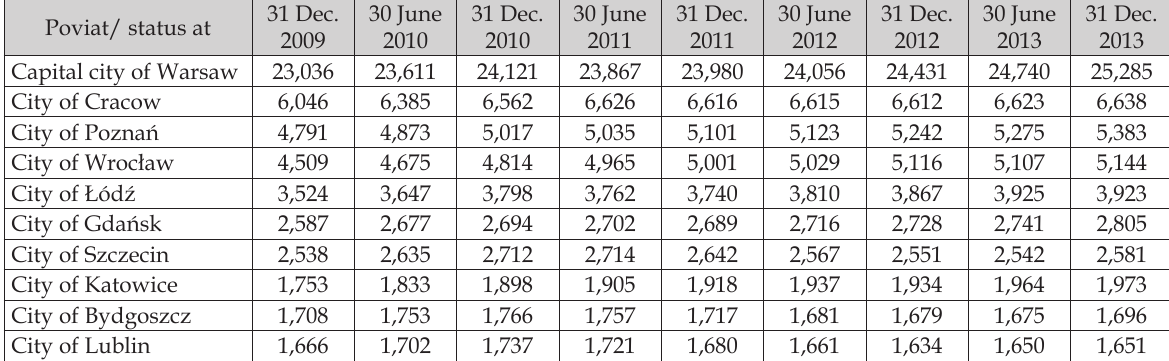
Table 3. Poviats with the biggest number of entities of the creative sector in Poland in the years 2009–2013. Poviat/ status at